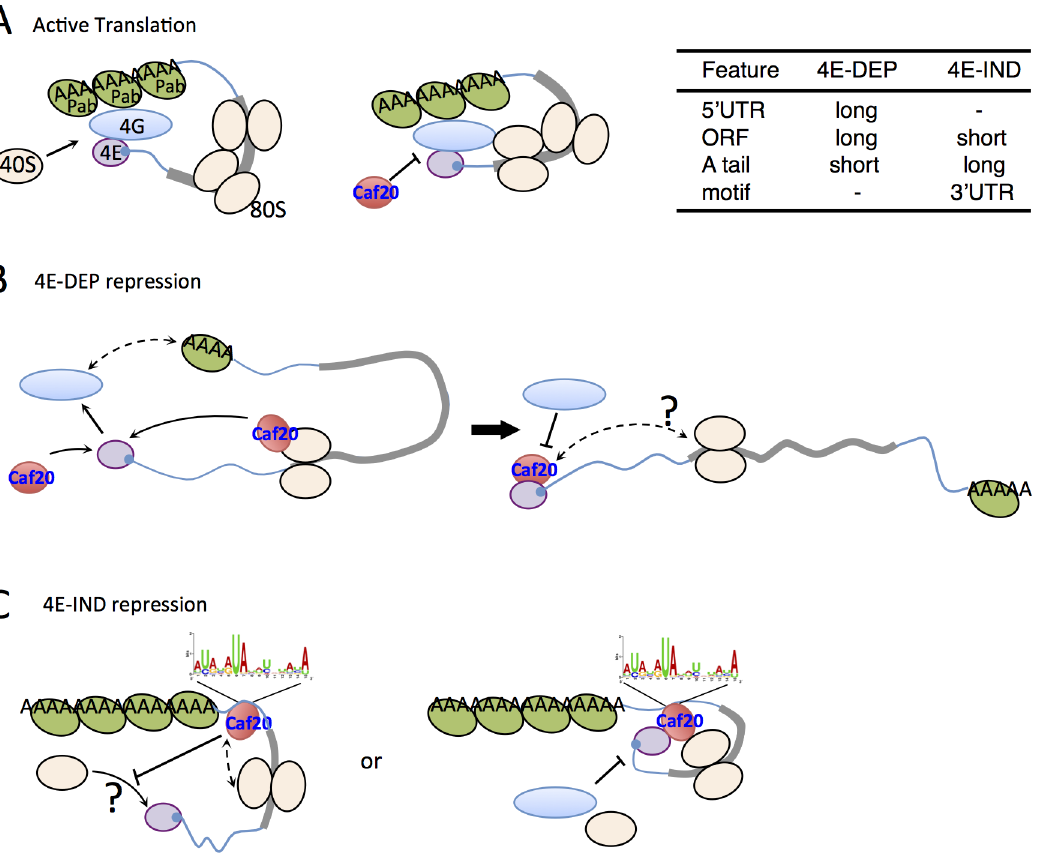
Fig 8. Models for 4E-DEP and 4E-IND Caf20p-mediated translational repression. A. Active translation. Short mRNA (blue line with grey ORF) shown with eIF4E (purple) bound to 5 ’ cap (blue), eIF4G (blue oval) and Pab1p (green oval) facilitating mRNA circularisation and ribosome recruitment (cream ovals) that excludes Caf20p binding eIF4E. B. Caf20p mediated eIF4E-dependent translational repression. eIF4E/4G/Pab1p closed loop unstable on long mRNAs facilitating Caf20p binding (red). Caf20p binding to 80S ribosomes may contribute to its local recruitment. C. 4E-IND repression mechanisms. Caf20p 3 ’ UTR motif binding (may not be direct), either alone or in addition to 80S binding facilitates translational repression. eIF4E-Caf20p binding may contribute to repression on some of these mRNAs.